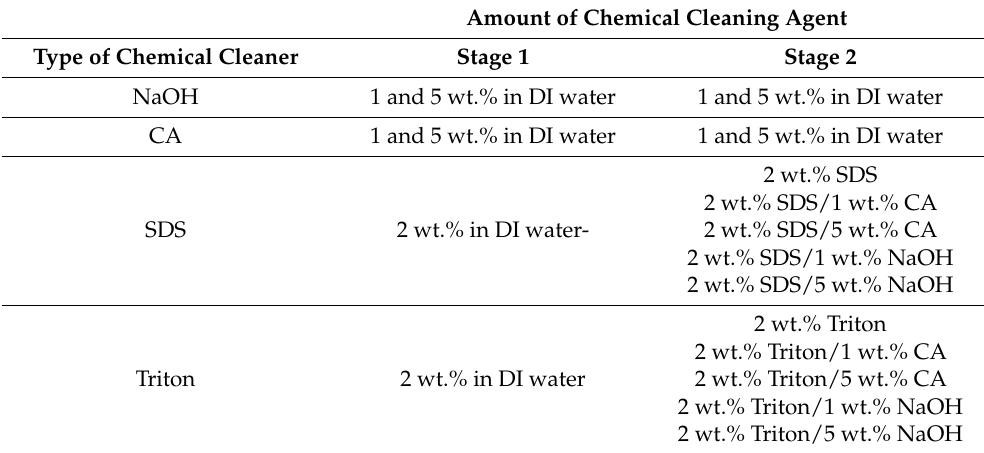
Table 3. The amount of cleaning agent used for the experimental stage 1 (chemical effects on the membrane surface) and stage 2 (the membrane chemical cleaning